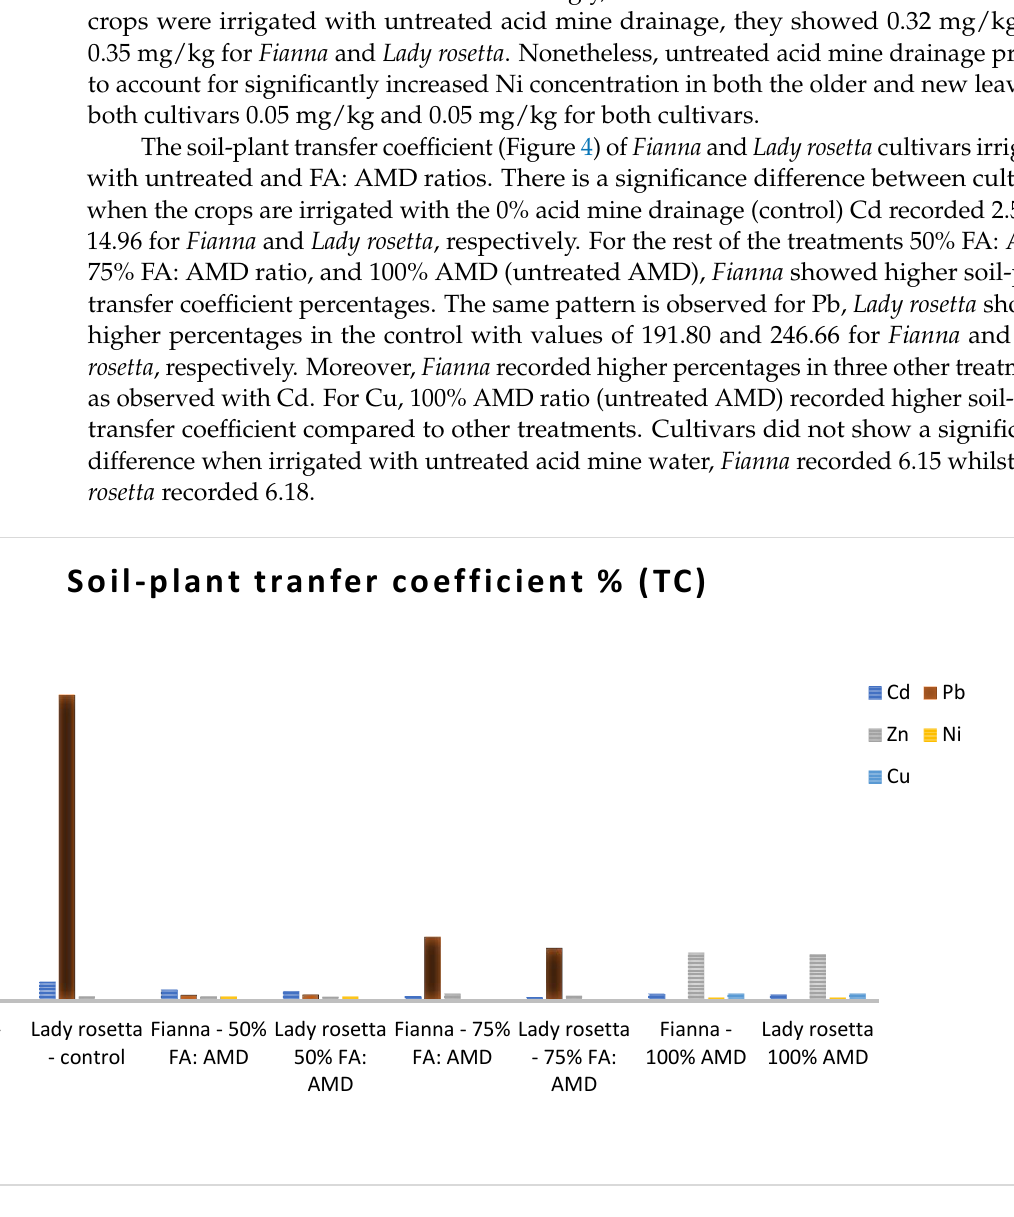
Table 2. Effect of AMD treatments on the bioaccumulation factor (BF) of two potato varieties ( Fianna and Lady rosetta ).